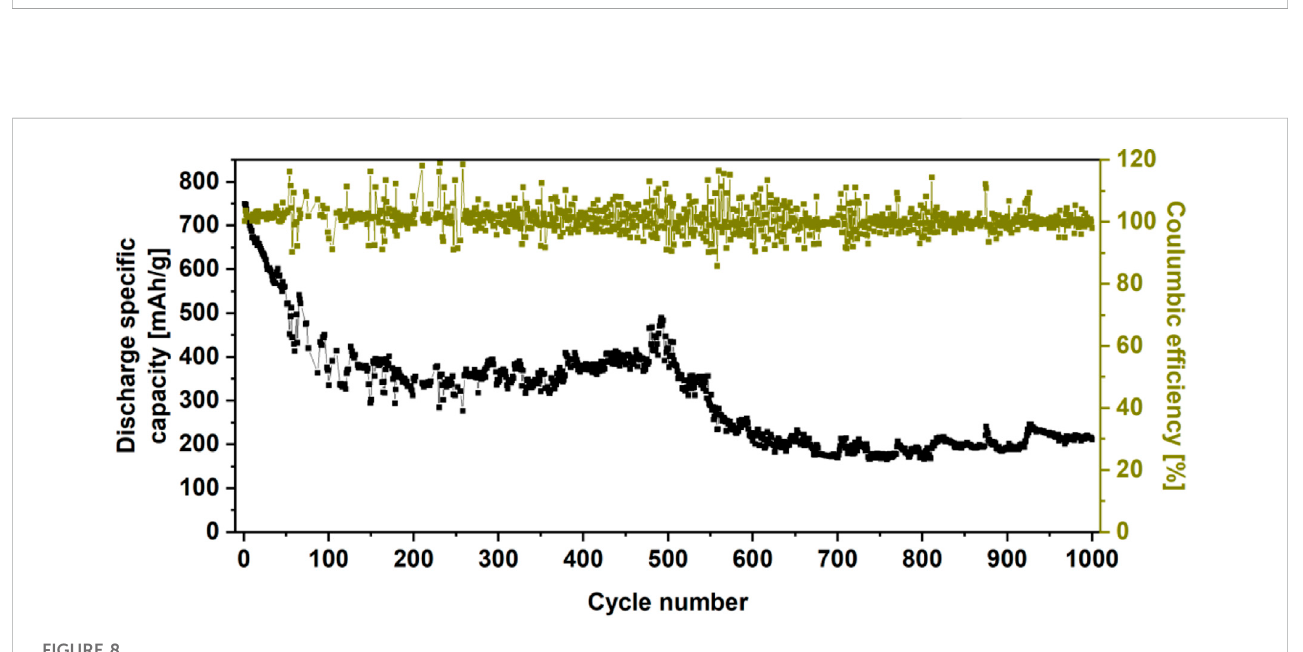
FIGURE 8 Cyclic performance of WS 2 /userGO1 recorded at 0.1